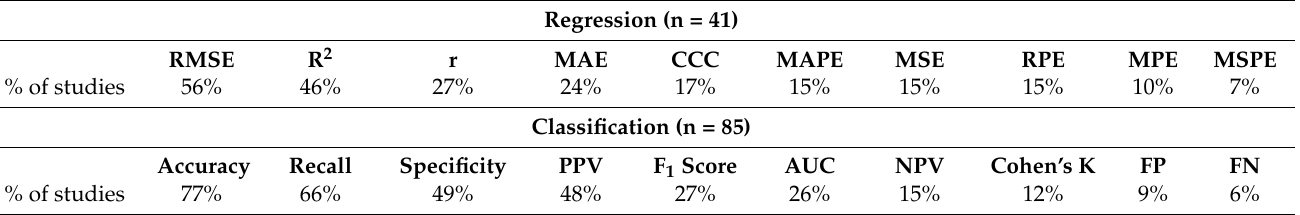
Table 1. Percentage of studies using each evaluation metric for classification and regression problems. Regression (n =